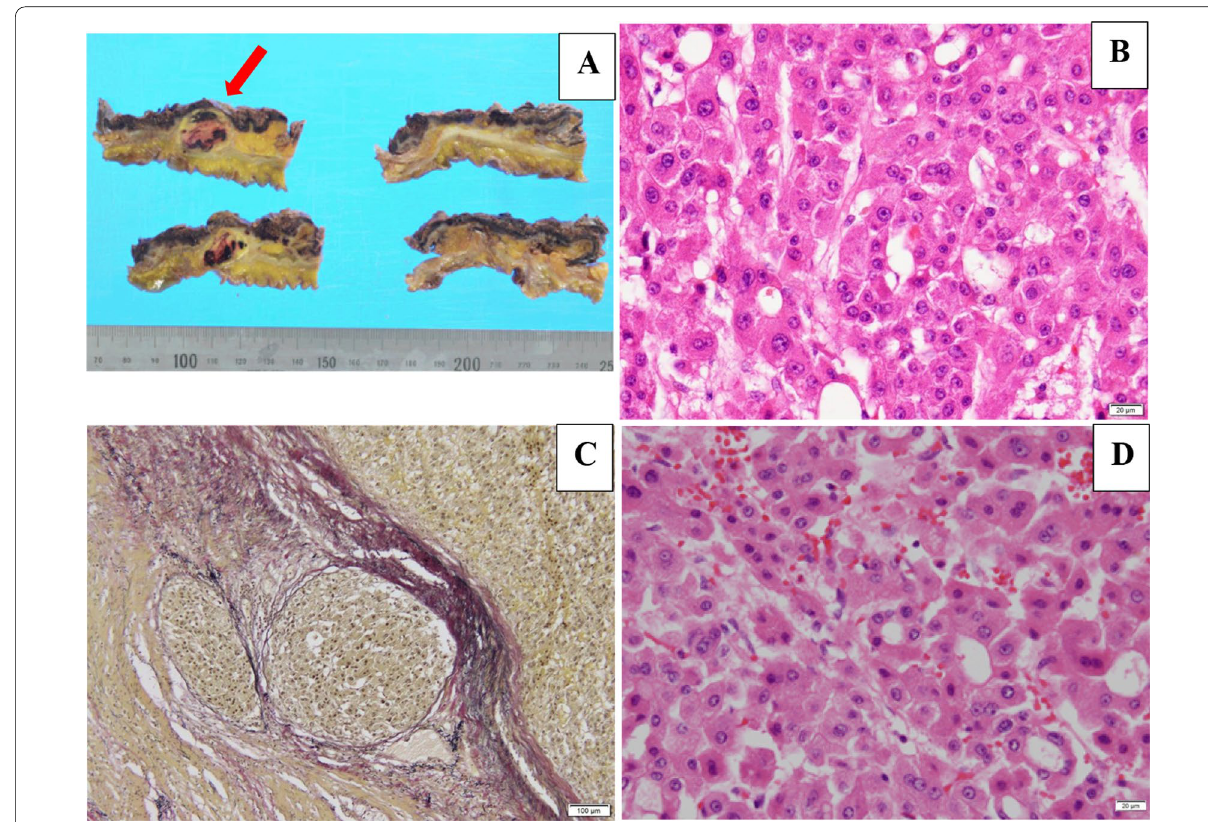
Fig. 3 Macroscopic and microscopic findings of the metastatic tumor in the ascending colon. A Macroscopic findings of the metastatic tumor. Colonic metastasis (Φ20 mm, red arrow) was mainly observed within the subserosal and muscularis layers in the ascending colon, along with a contiguous retroperitoneal hematoma. B Microscopic findings revealed a moderately differentiated type of HCC. C The Elastica-van Gieson stain showed vascular invasion of the metastatic tumor. D Microscopic findings of primary